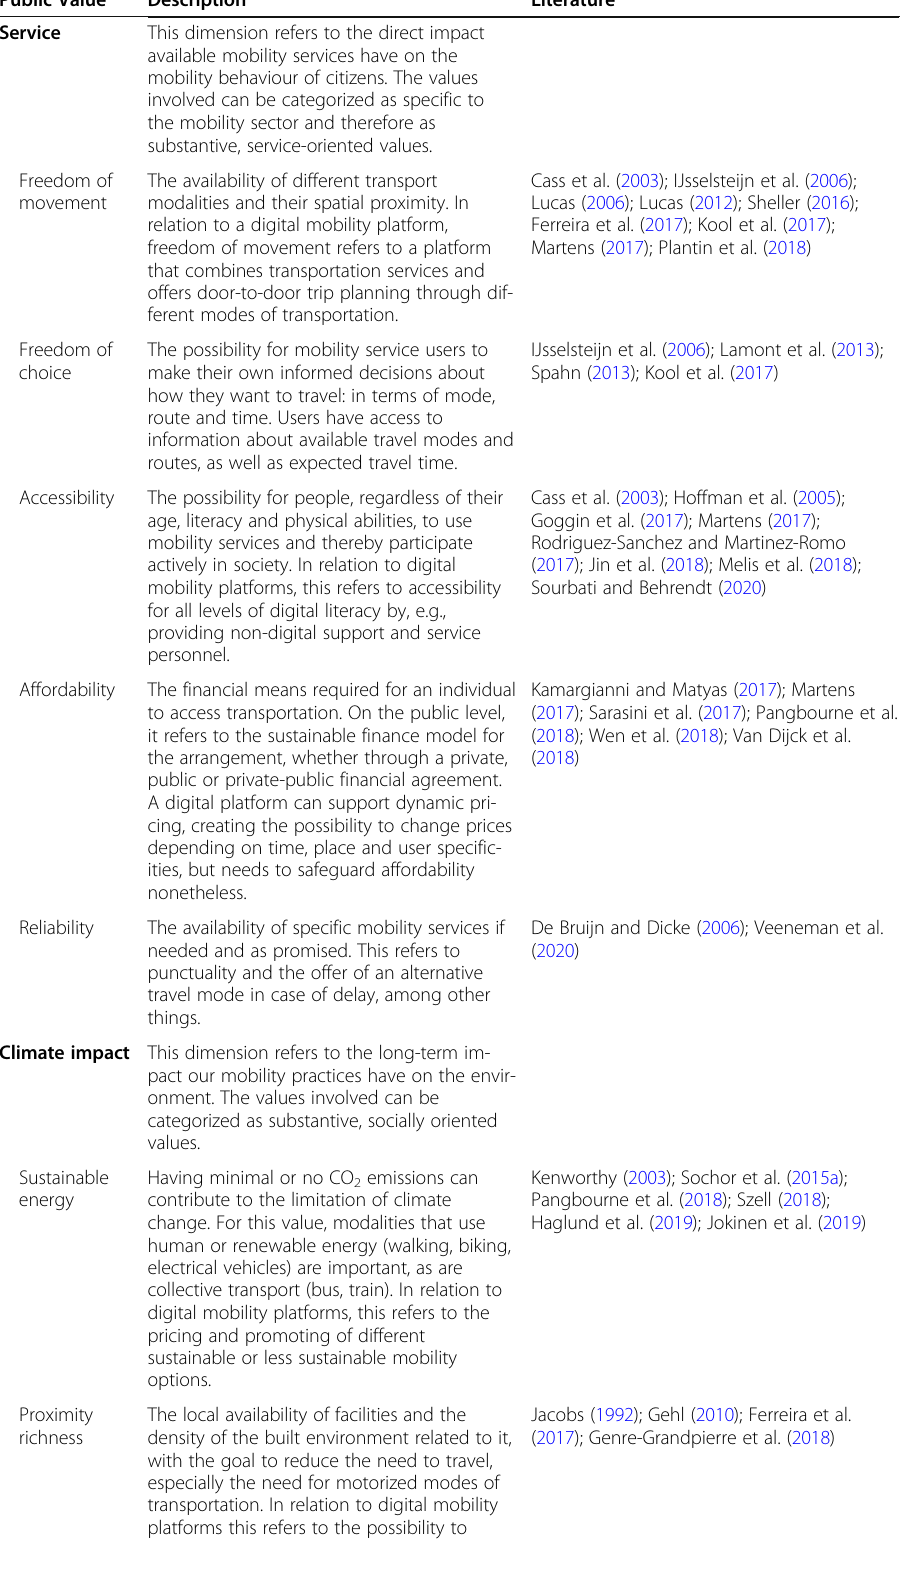
Table 3 The assessment framework with the four theoretical dimensions, value descriptions